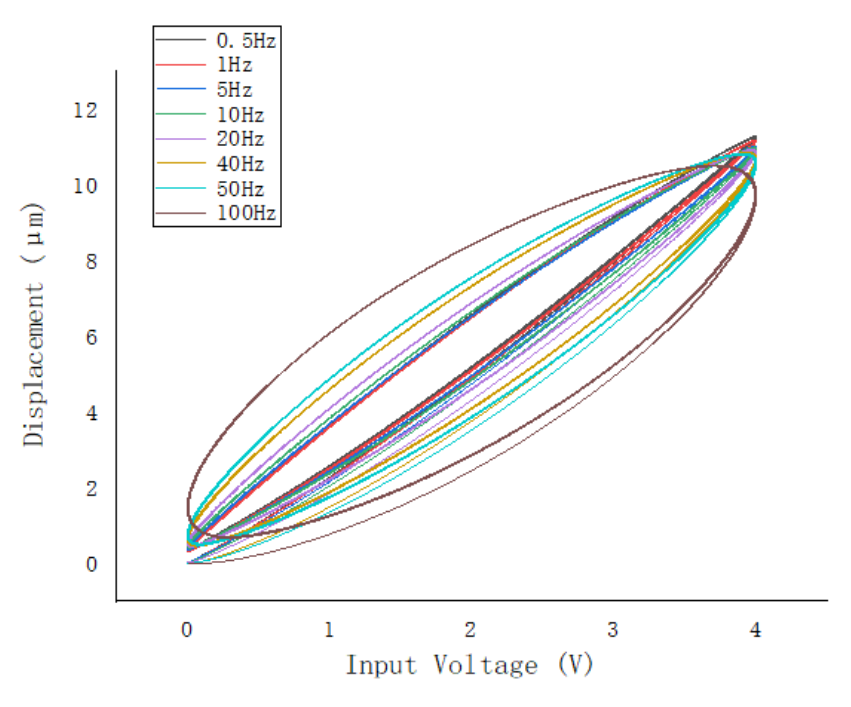
Figure 1. Rate-dependent hysteresis characteristics of piezoelectric actuator (PEA).